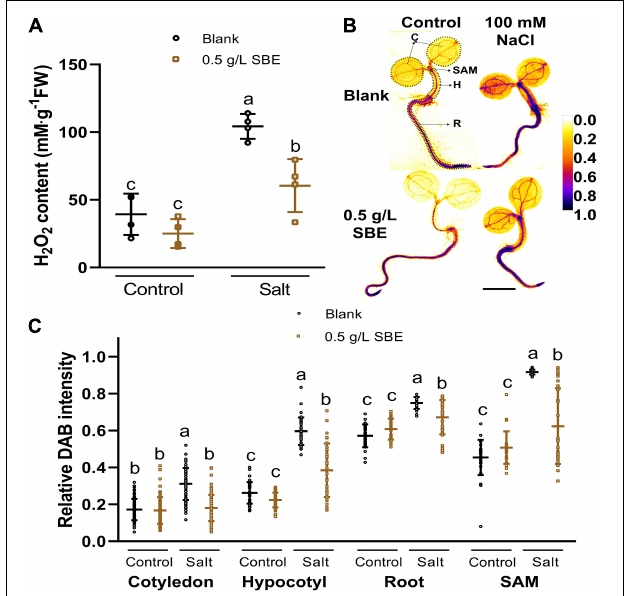
FIGURE 8 | The antioxidant activities of Arabidopsis seedlings under salt stress at 10 DAG in the true leaf assay. (A) SOD activity, (B) CAT activity, (C) APX activity, (D) POX activity. Error bars indicate SDs of the means. Different letters represent significant differences between treatments using Tukey’s HSD test ( p < 0.05). SBE, sunflower bark extract; DAG, days after germination; U, enzyme activity unit ( µ mol/min); SOD, superoxide dismutase; CAT, catalase; APX, ascorbate peroxidase; POX,